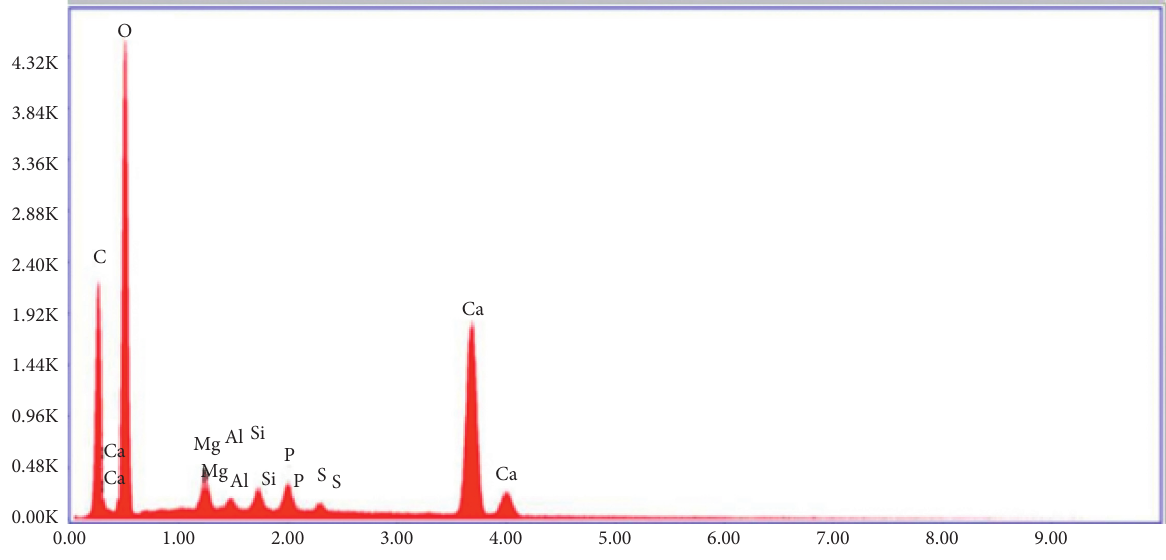
Figure 3: EDX of sugar scum